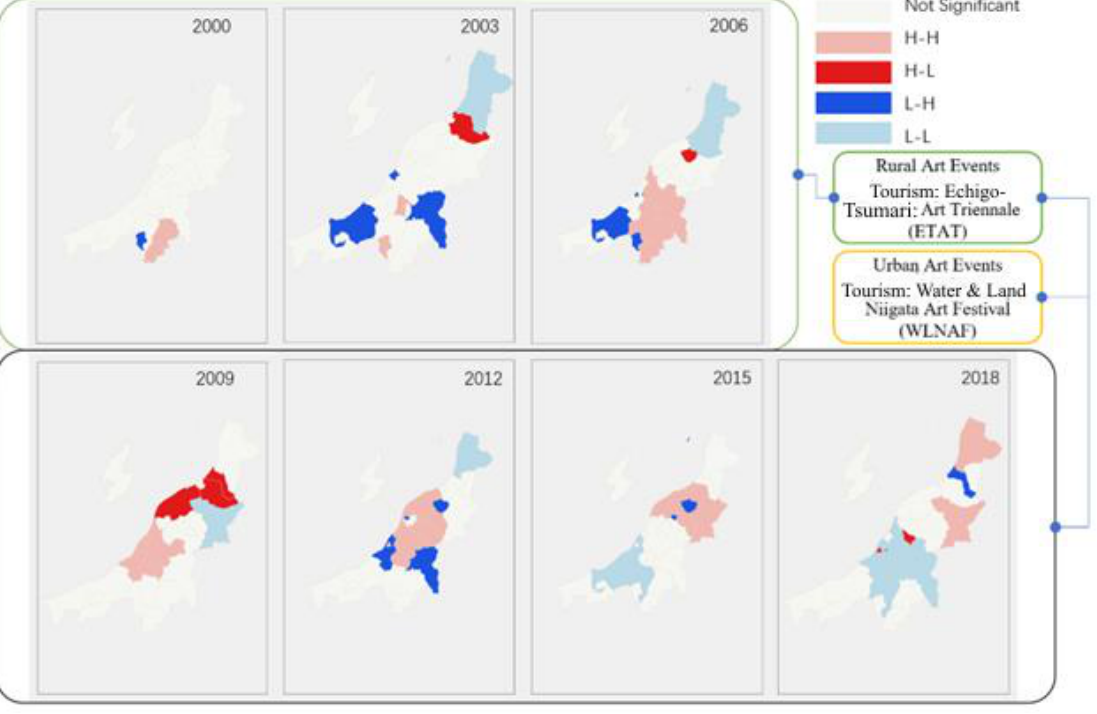
Figure 14. Local indicators of spatial association (LISA) of the tertiary industry income growth rate (TIIGR).